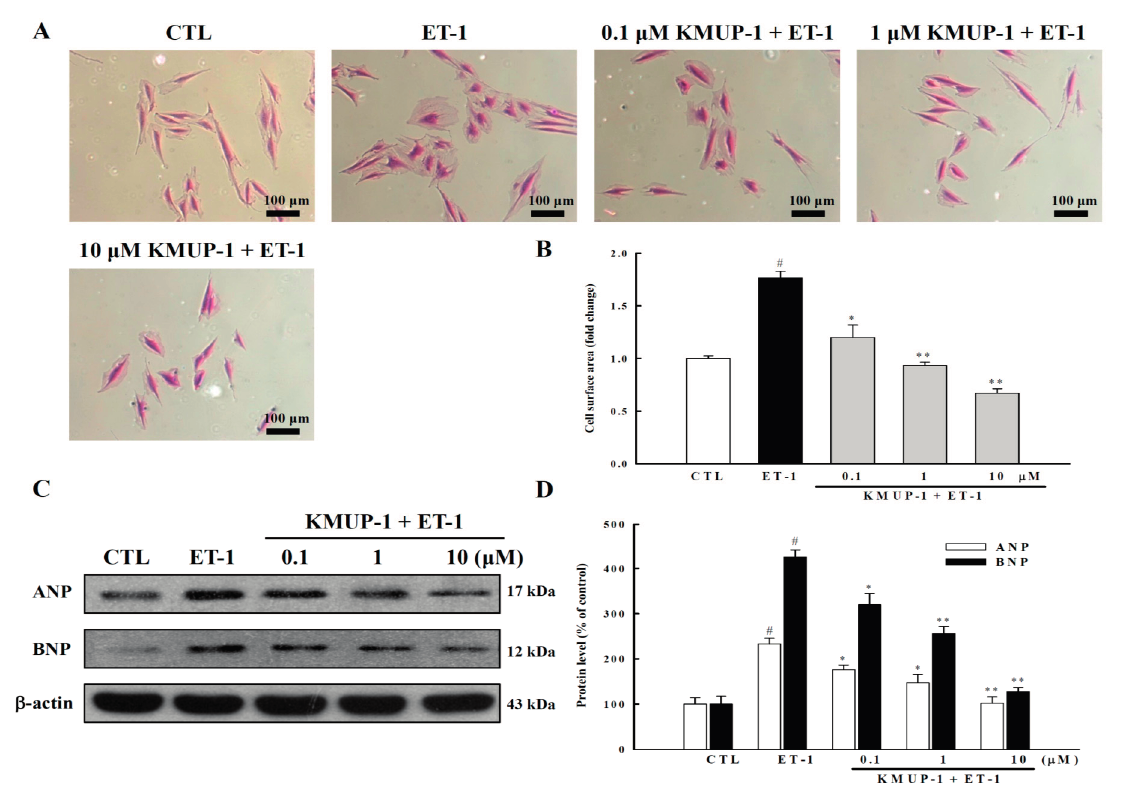
Figure 1. Effects of different doses of KMUP-1 on cell surface area, ANP and BNP protein expressions in myocytes treated with ET-1 (100 nM) for 4 days. ( A ) Representative micrographs of cardiomyocytes (200×); ( B ) Cell surface area was determined by planimetry, and >100 cells were analyzed per condition in six repeated experiments; ( C , D ) Expressions of ANP and BNP proteins. Each value represents the mean ± SEM of three independent experiments, with triplicate determinations in each experiment. # p < 0.01 compared with control; * p < 0.05, ** p < 0.01 compared with ET-1